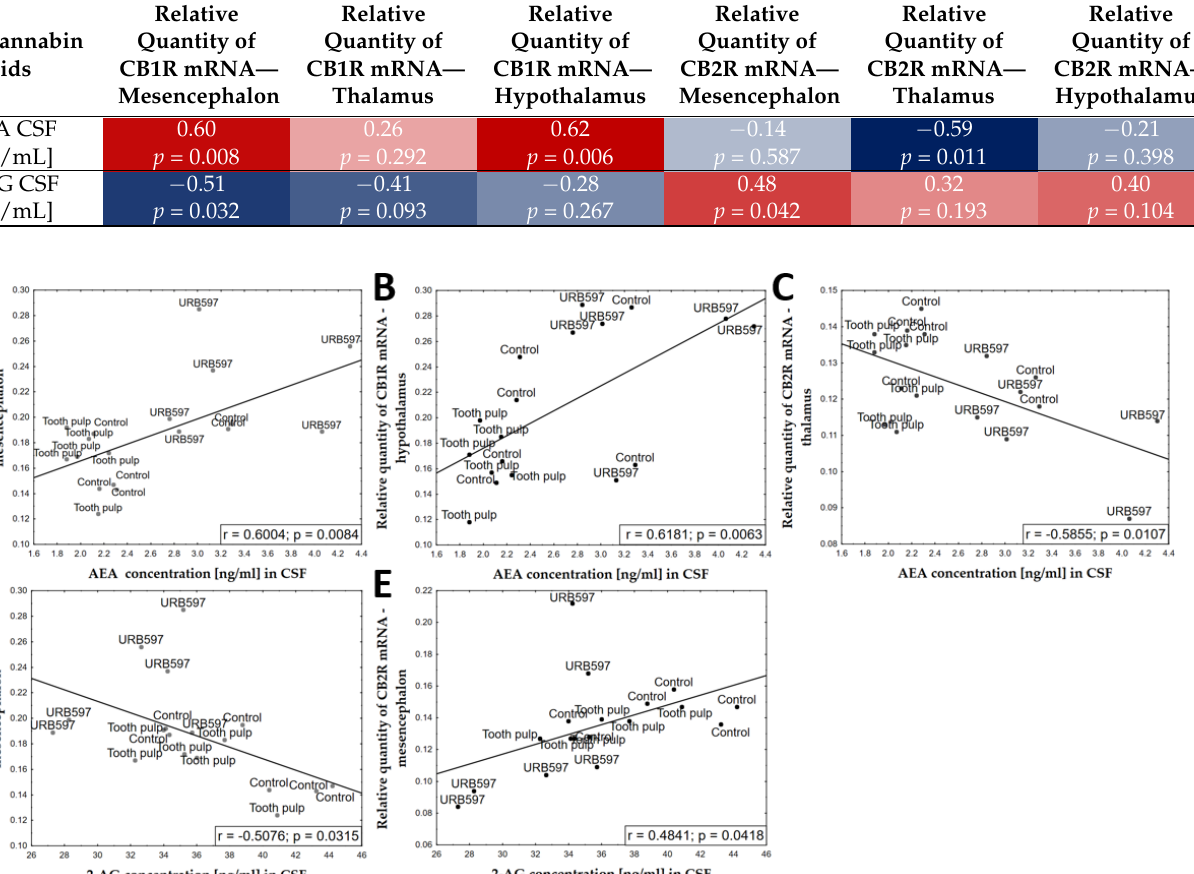
Table 2. Pearson correlation coefficients and associated p -values for endocannabinoids (AEA/ 2-AG) and the expression of CB1R/CB2R. Blue indicates negative R values and red indicates positive R values.